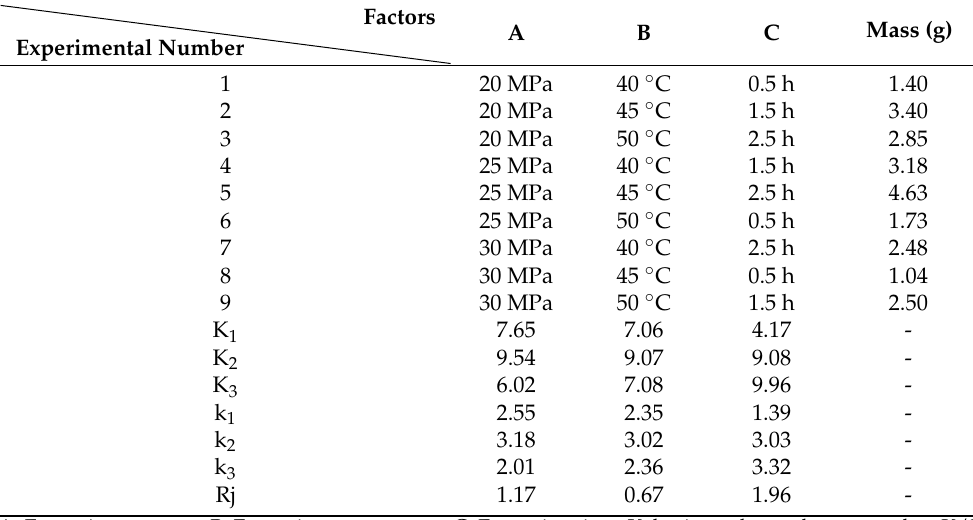
Table 2. Orthogonal test results of supercritical CO 2